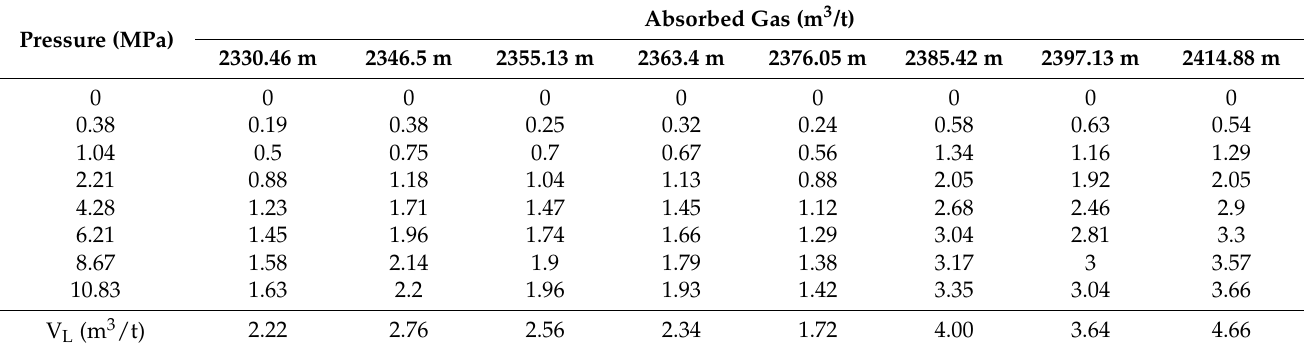
Table 2. Methane absorption data of Wufeng-Longmaxi Formation in Well